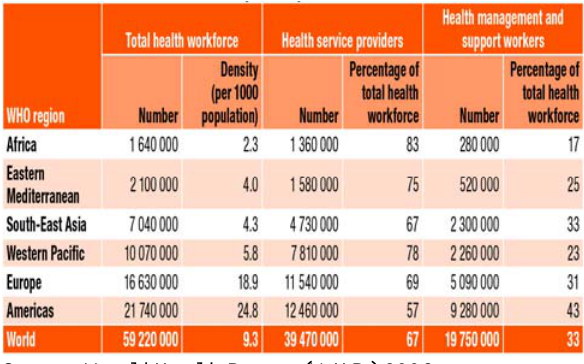
Table 1 : Global health workforce, by density